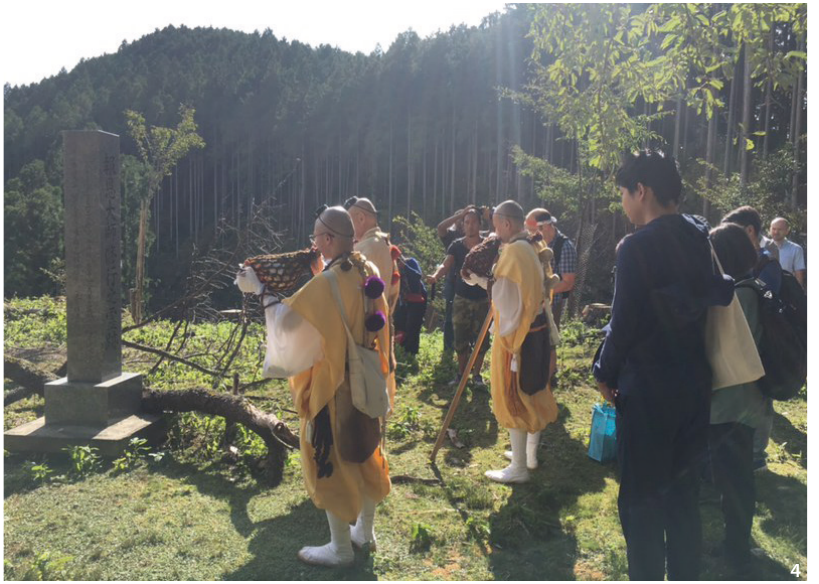
Figure 4 Shugendo pilgrimage, Kii Mountains (Source: the author).